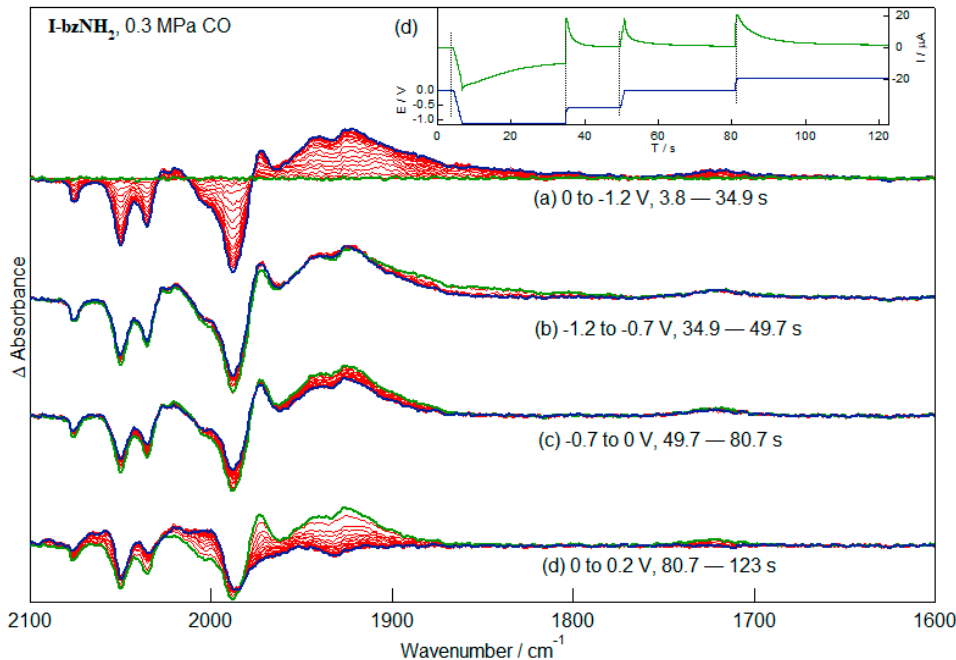
Figure 7. IR-SEC of I-bzNH 2 (2 mM, CH 3 CN, 0.2 M TBAPF 6 ) with CO (ca. 0.3 MPa). The spectra show the reduction ( a ) and re-oxidation at increasingly positive potentials ( b – d ). The applied potential and